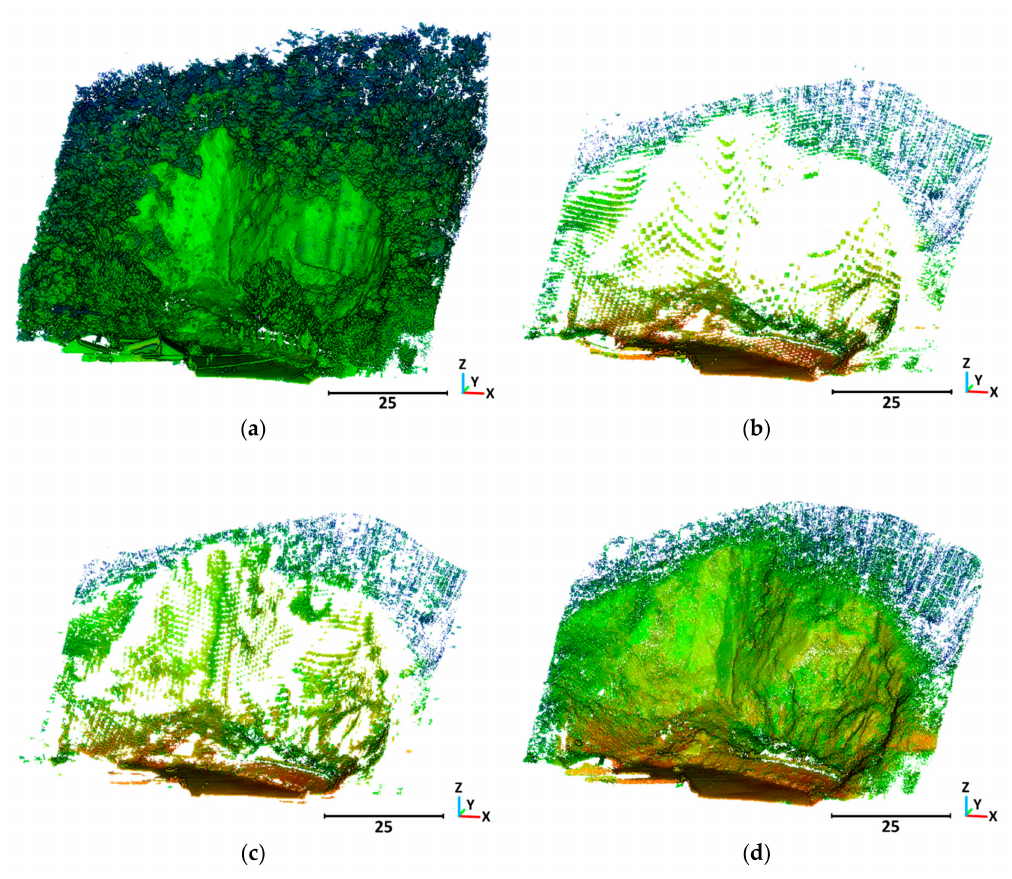
Figure 8. Filtering result of site A: ( a ) original data; ( b ) the lowest points; ( c ) seed points for PCA-TIN (Principal Component Analysis–Triangular Irregular Network); ( d ) final